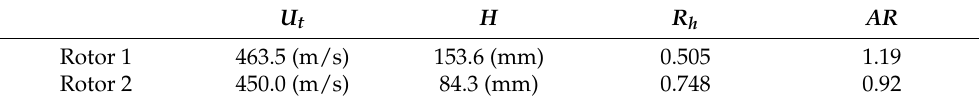
Figure 1. The meridian views of the baseline two-stage transonic compressor in ( a ) single flow-path mode (SFM) and ( b ) double flow-path mode (DFM); ( c ) the geometry parameter for IGV. For the baseline compressor, Stage 1 has a load coefficient ψ t = 0.40 with a flow coefficient φ t = 0.40, which is of high aerodynamic load level. Stage 2 has a lighter load coefficient ψ t = 0.26 with a flow coefficient φ t = 0.44. As shown in Table 3, Rotor 1 and Rotor 2 have relatively high blade tip tangential velocity U t of 463.5 m/s and 450.0 m/s, respectively. The hub-to-tip ratios (cid:1844) (cid:2918) at the leading edge of Rotor 1 and Rotor 2 are 0.505 and 0.748, respectively. The low aspect ratio ( (cid:1827)(cid:1844) = (cid:1834)/(cid:1829) ) design is used in both Rotor 1 and Rotor 2 to improve the chord length for enhancing the blade Reynolds number and blade structure strength. Table 3. One-dimensional design parameter of the rotors in baseline transonic compressor.